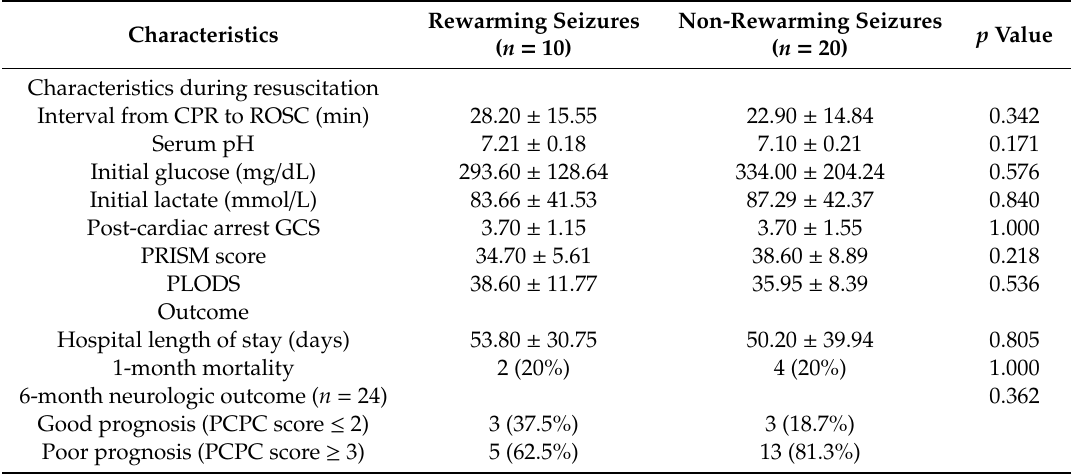
Table 2. Variables during and after resuscitation and outcomes of the 30 children undergoing therapeutic hypothermia after